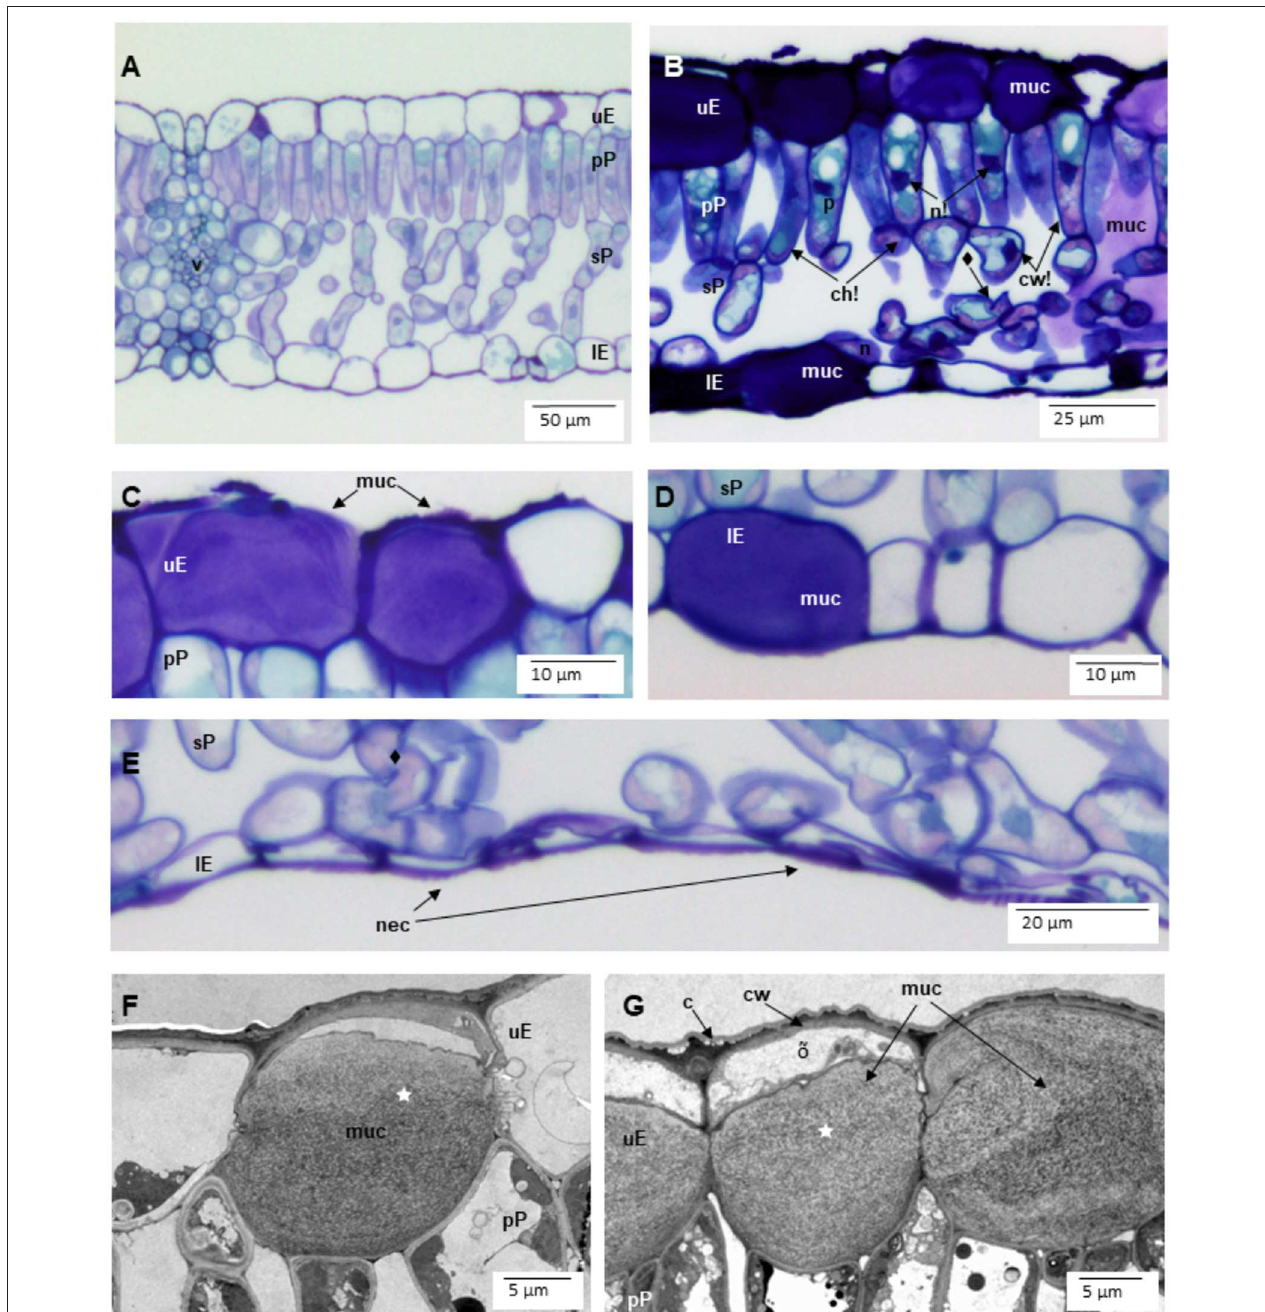
FIGURE 2 | Symptoms of biotic injury, primarily by aphids, in leaves of Tilia x vulgaris trees from the street greenery of Riga and National Botanic Garden (NBG) in Latvia. (A) nearly asymptomatic leaf tissues. (B) in the leaf blade, the severely affected leaf parts showed a higher frequency of mucilages (muc) within upper (uE), and lower (lE) epidermis as well as mucilage spills in the intercellular space of palisade (pP) and spongy (sP) parenchyma. Mesophyll cells showed cell wall thickening (cw!), nucleus (n!), and chloroplast (ch!) condensation as well as increased amounts of vacuolar phenolics (p). Some cells were partially cytorrhised ( (cid:7) ). (C,D) mucilage structure in upper (C) and lower (D) epidermis (lE). (E) cytorrhisis indicative of necrosis (nec) in lower epidermis. (F,G) mucilage within epidermal cells showed a mostly granular structure, with banding patterns ( ⋆ ). Cell death was evidenced by disrupted protoplasm remnants (õ). Other abbreviations: c cuticula. Na, Cl concentration: 2,660, 5,000 ppm (A) , 124, 5,000 ppm (B) , 72, 530 ppm (C,D) , 8,800, 6,896 ppm (E) , 4,180, 11,500 (F) , 5200, 10750 (G) . Technical specifications: (A–E) : 1.5 µ m semi-thin cuttings stained with toluidine blue and acid fuchsine and observed in diascopic light microscopy; (F,G) : 70nm ultra-thin sections stained with uranyl acetate and lead citrate and observed in transmission electron